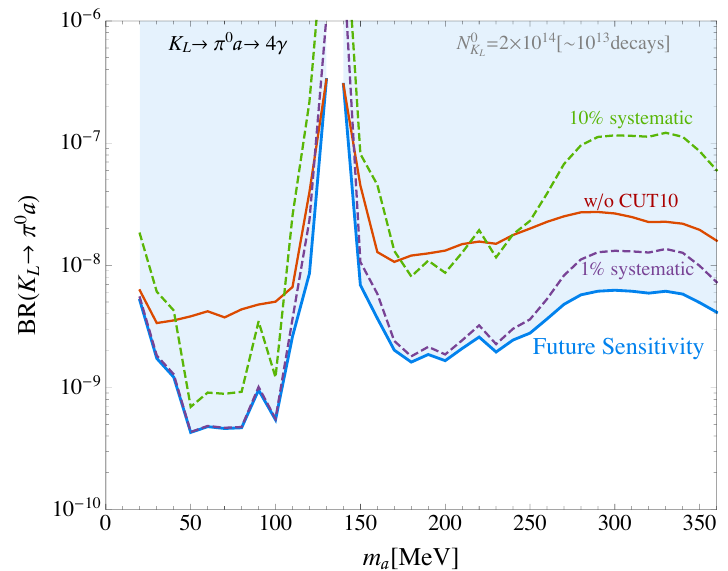
p B (cid:8) 0 : 01 B ),